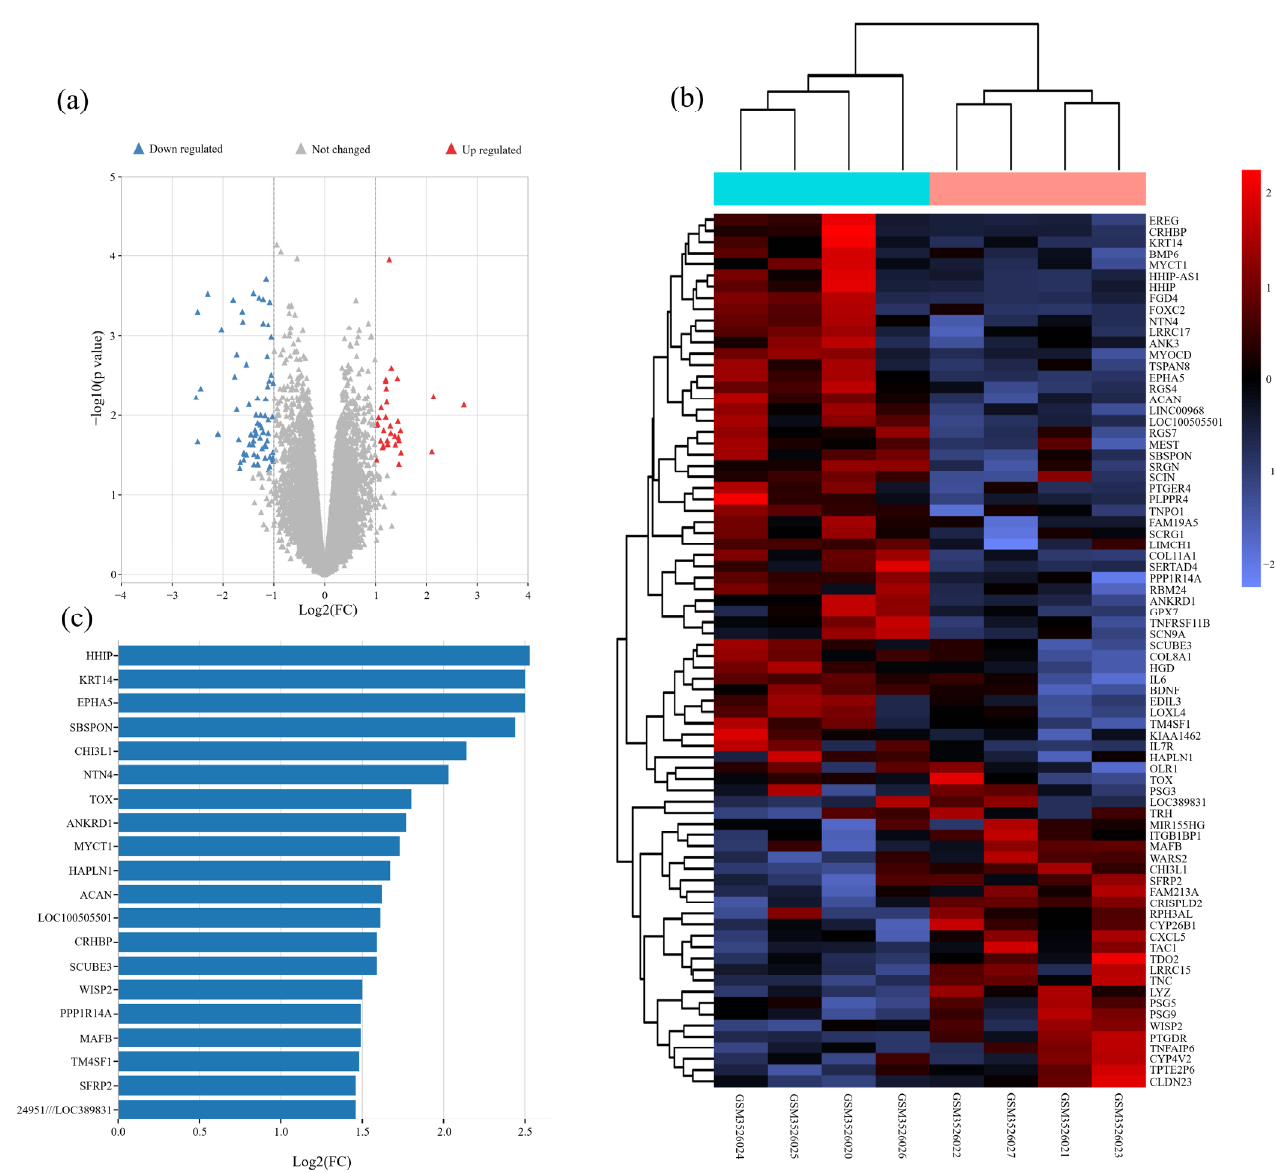
Figure 1. Bioinformatics analysis for PCOS related genes and signaling pathways in PCOS women. ( a ) Volcano map of DEGs from abdominal adipose stem cells of PCOS women and healthy women. ( b ) Clustering analysis of genes from abdominal adipose stem cells of PCOS women and healthy women. ( c ) The sequence of the top 20 genes with the highest degrees.